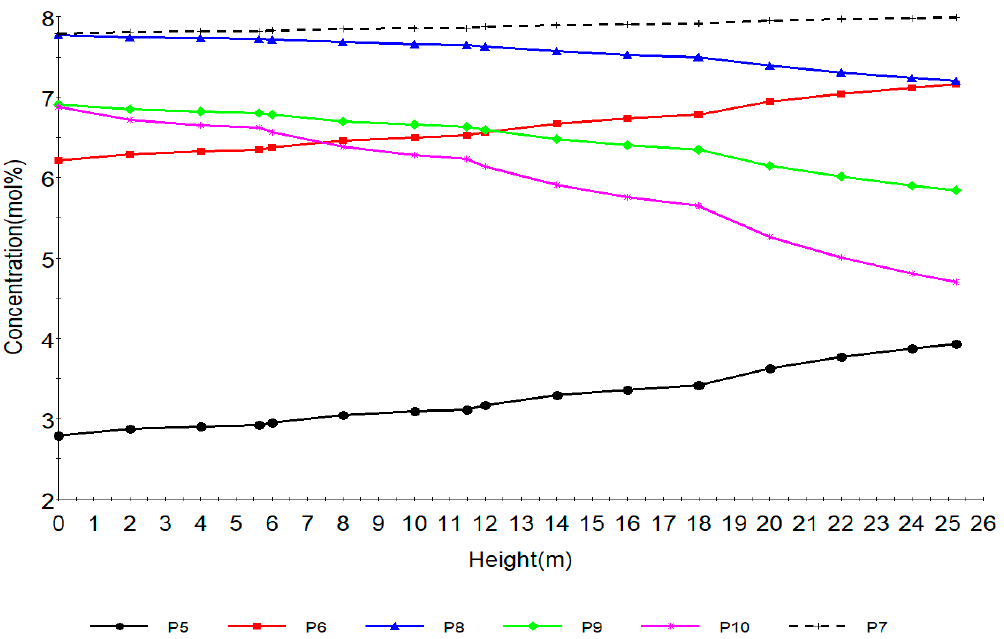
Figure 4. Concentration profile of paraffins with total height of reactors.